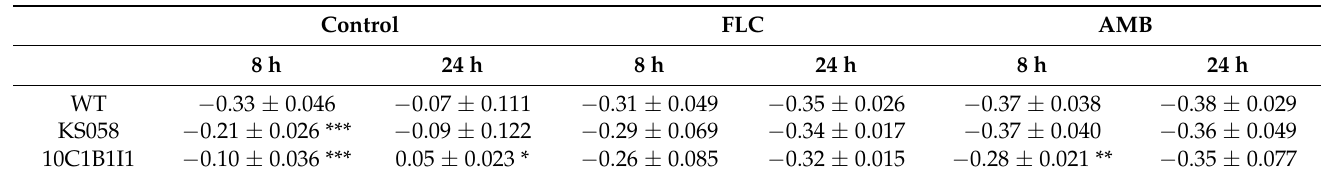
Our analysis showed that the C. albicans KS058 and 10C1B1I1 strains at 8 h of culture exhibit significantly higher GP values ( − 0.21 and − 0.10, respectively), highlighting the cor- relation between both the deprivation and the overproduction of ergosterol and decreased PM fluidity. The representative, normalized fluorescence intensities spectra for the inves- tigated strains in 8 h or 24 h of culture are presented in Figure 3.